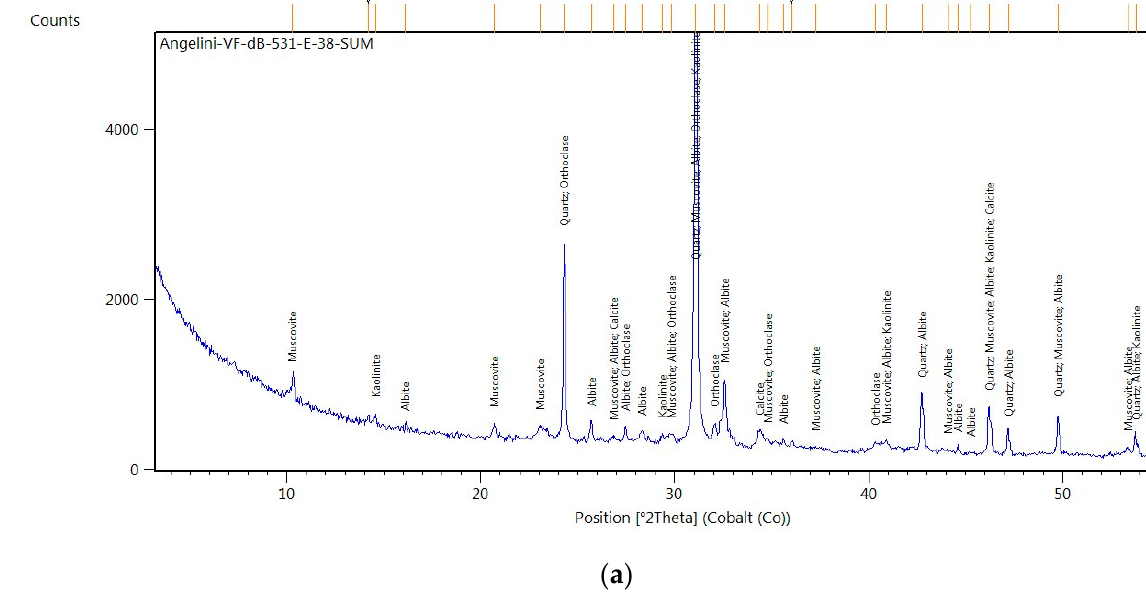
Figure 4. ( a ) XRPD diffractogram measured on the red coating of dice VF14.SP384D; ( b ) Raman spectroscopic signal of one red grain (blue spectrum) and one red-orange grain (red spectrum) present in the red coating of the same dice, compared with the spectra of two reference hematite (green and dark blue) and two red ochre samples (pink and cyan).